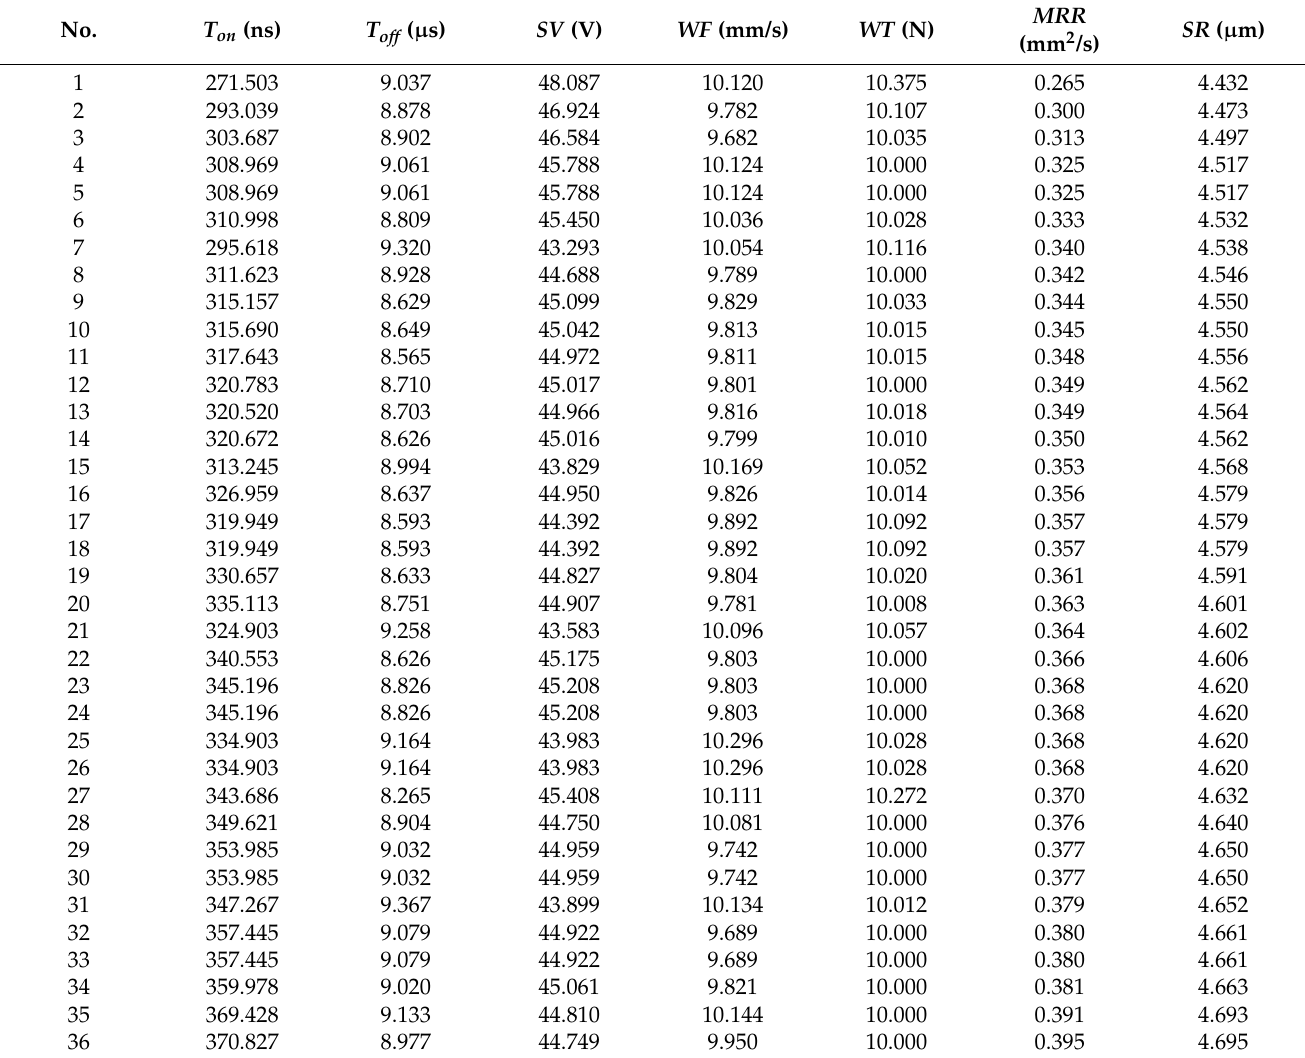
Figure 12. The partial Pareto optimal solution of MRR and SR . Table 7. Partial solution set of multi-objective optimization algorithm.